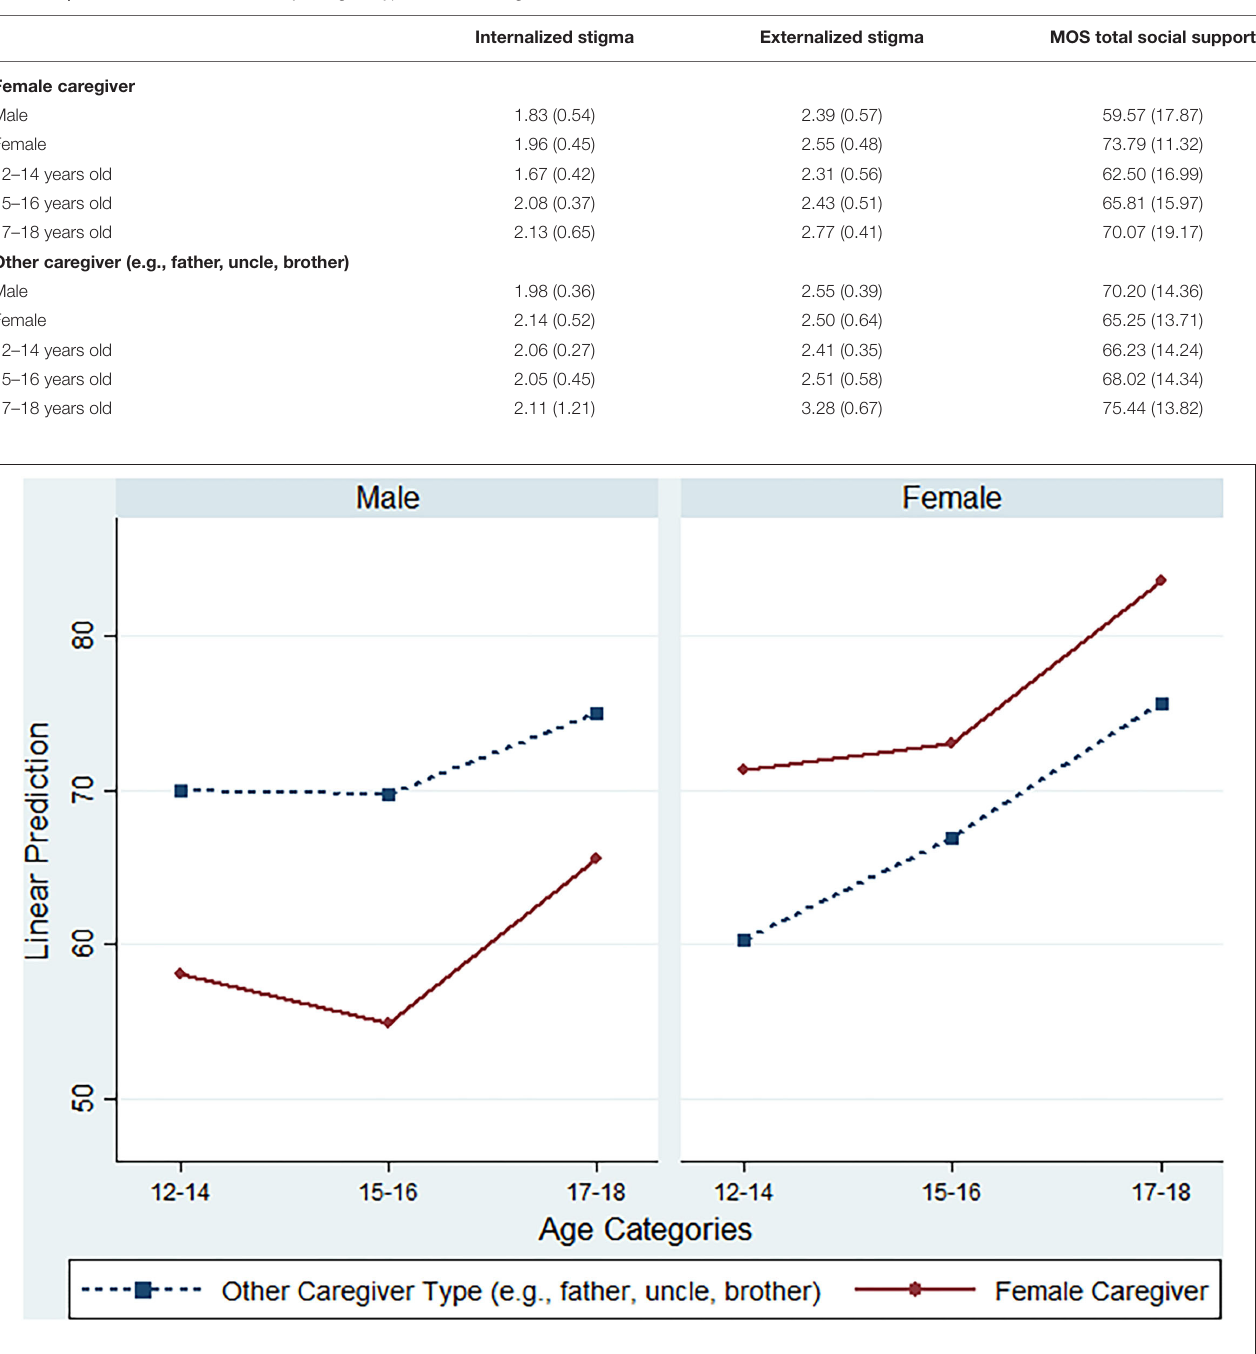
FIGURE 1 | MOS total social support margins by caregiver type, sex, and